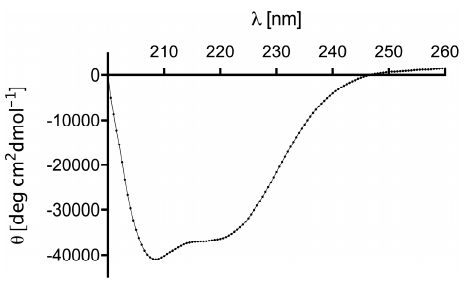
Figure 2. Circular dichroism (CD) spectrum of the diaffibody confirms a predominant α -helical secondary structure. Inset summarizes secondary structure content of (Z HER2:4 ) 2 DCS . Figure 3. Normalized thermal denaturation (black line) and renaturation (dashed line) of (Z HER2:4 ) 2 DCS monitored by ellipticity changes.